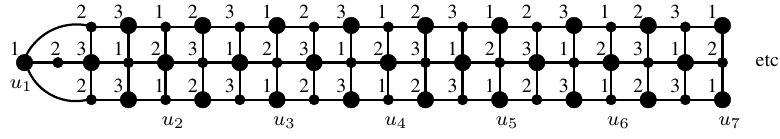
Figure 1: The vertex gadget for the reduction of Theorem